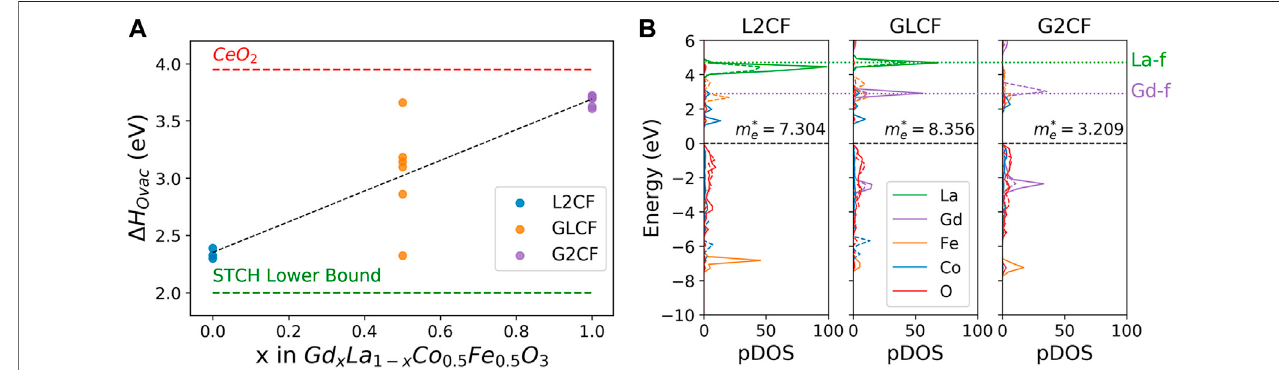
FIGURE1 |(A) Computed Δ H Ovac values vsGd concentration (x) in Gd x La 1-x Co 0.5 Fe 0.5 O 3 , showing that higher xincreases Δ H Ovac , thus the stability of oxygen. All threematerialsstudiedarewithintheestimatedSTCHactiverange(2.0 eV ≤ Δ H Ovac ≤ 3.95 eV).Themeanvacancyenthalpy Δ H Ovac isdescribedbytheequation, Δ H Ovac (cid:1) 1.34x + 2.35 ( R 2 (cid:1) 0.999), where x is the fractional concentration of Gd on the A site. (B) DFT computed DOS for La Gd